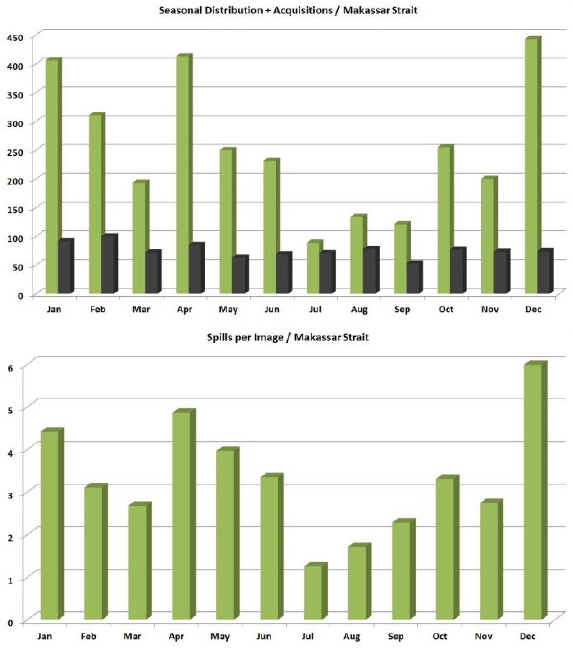
Figure 10. Same as Figure 9, but for the ROI ‘Makassar